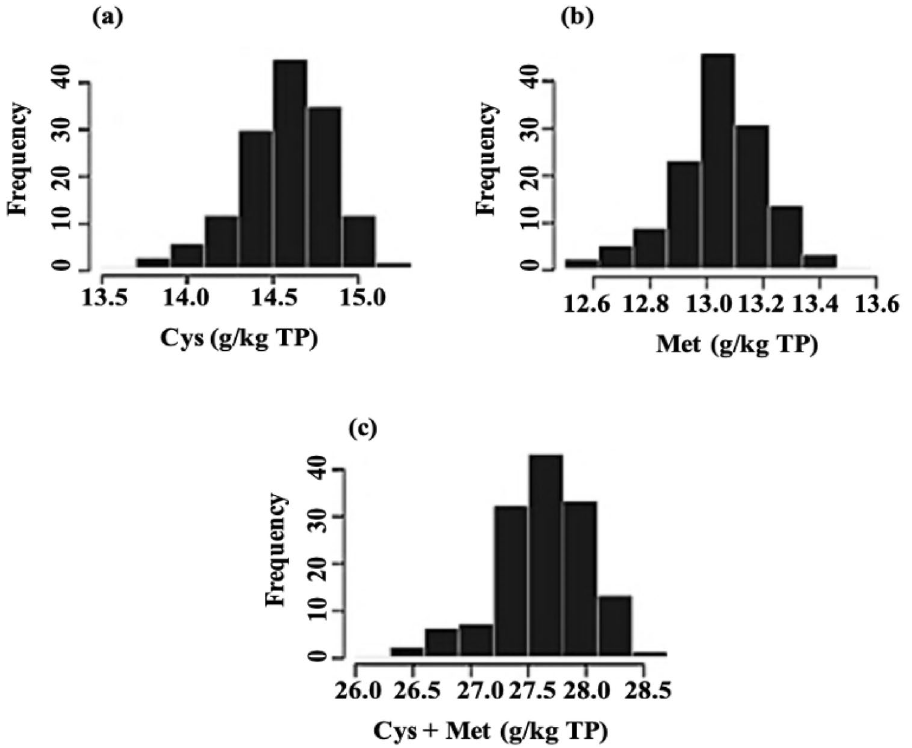
Figure 1. Distribution of Cys ( a ), Met ( b ) and ( c ) Cys + Met content (g/kg of total protein) in the seed of 137 Canadian soybean lines.